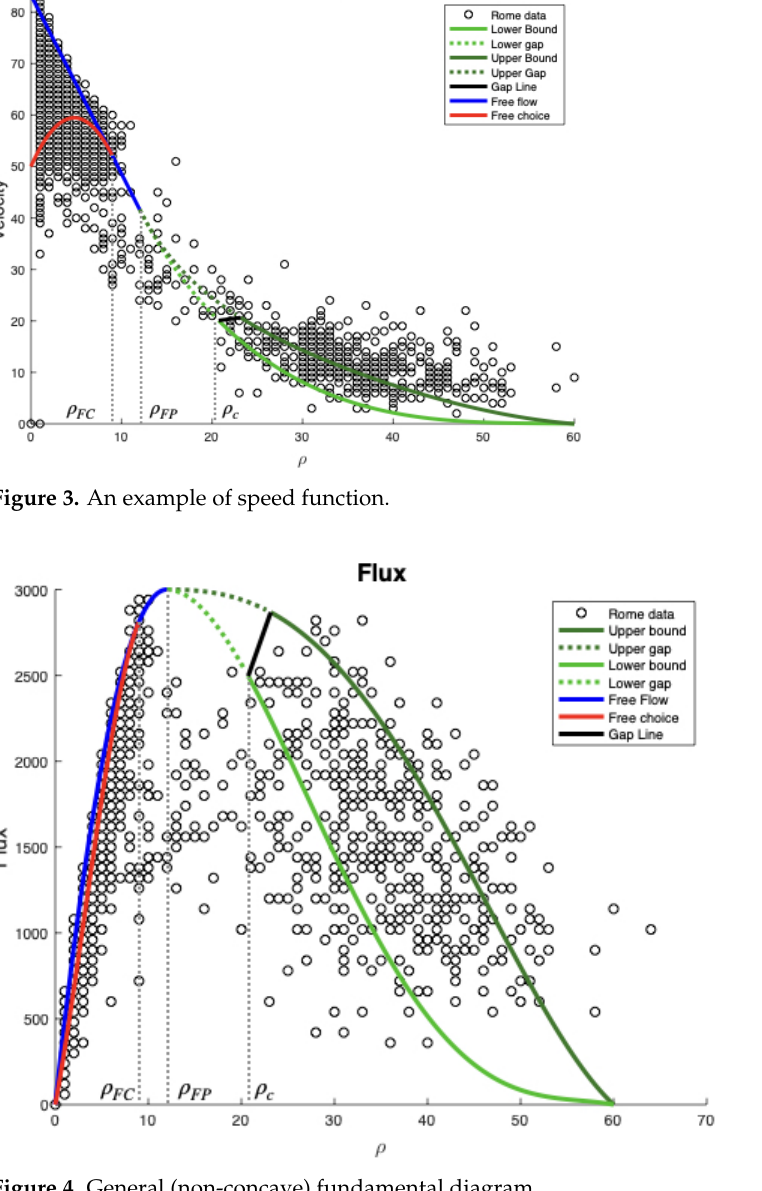
Figure 4. General (non-concave) fundamental